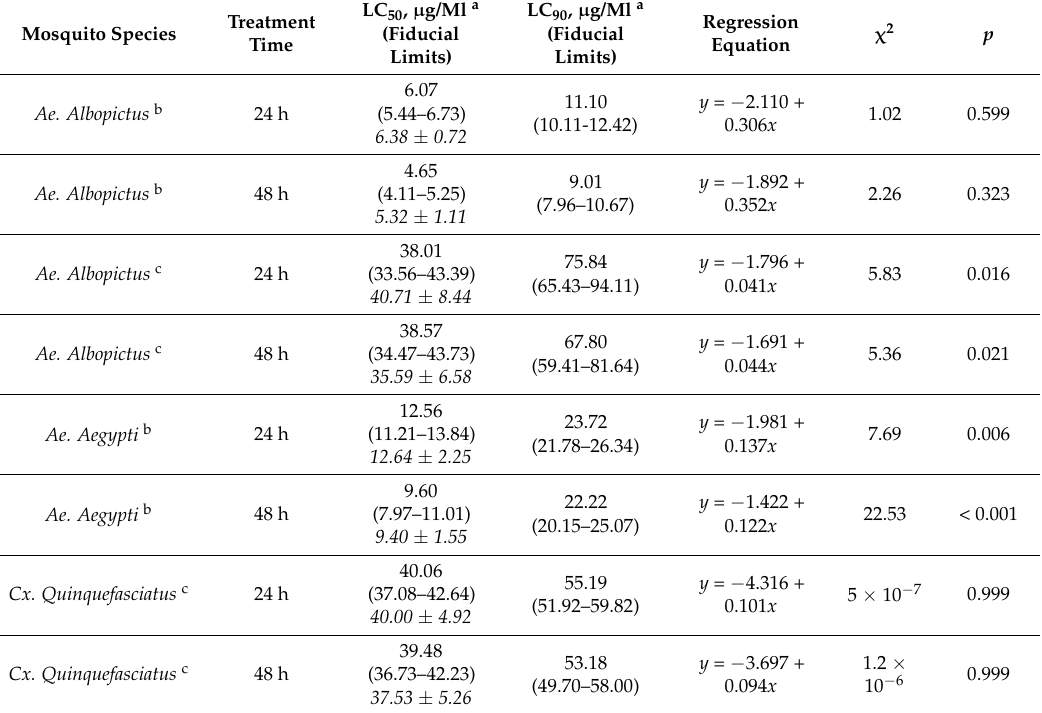
Table 5. Mosquito larvicidal activity of Erechtites valerianifolius aerial parts (leaves and stems) essential